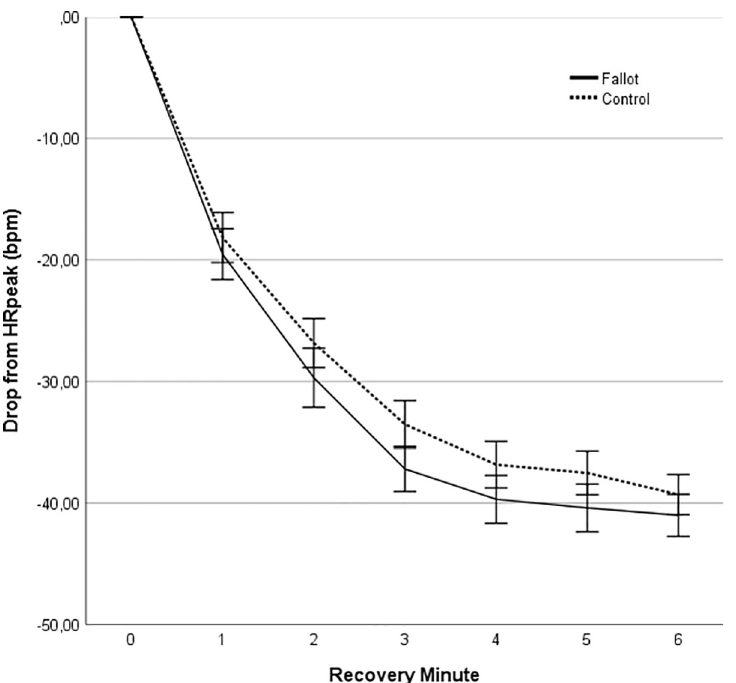
Fig 3. Heart rate recovery (beats per minute) during the 6 min of